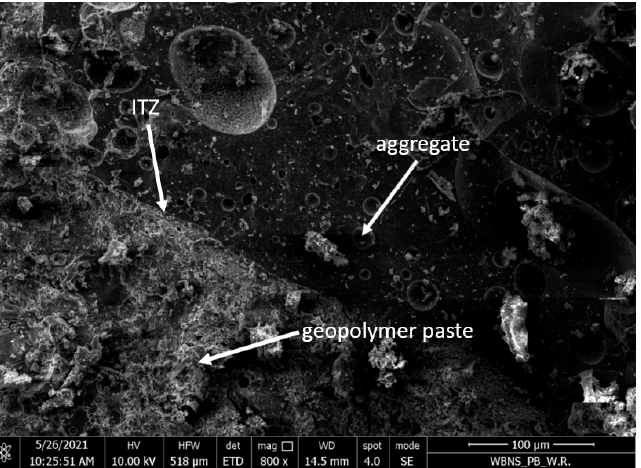
Figure 13. ITZ between impregnated lightweight aggregate and geopolymeric paste (magnification 800×).